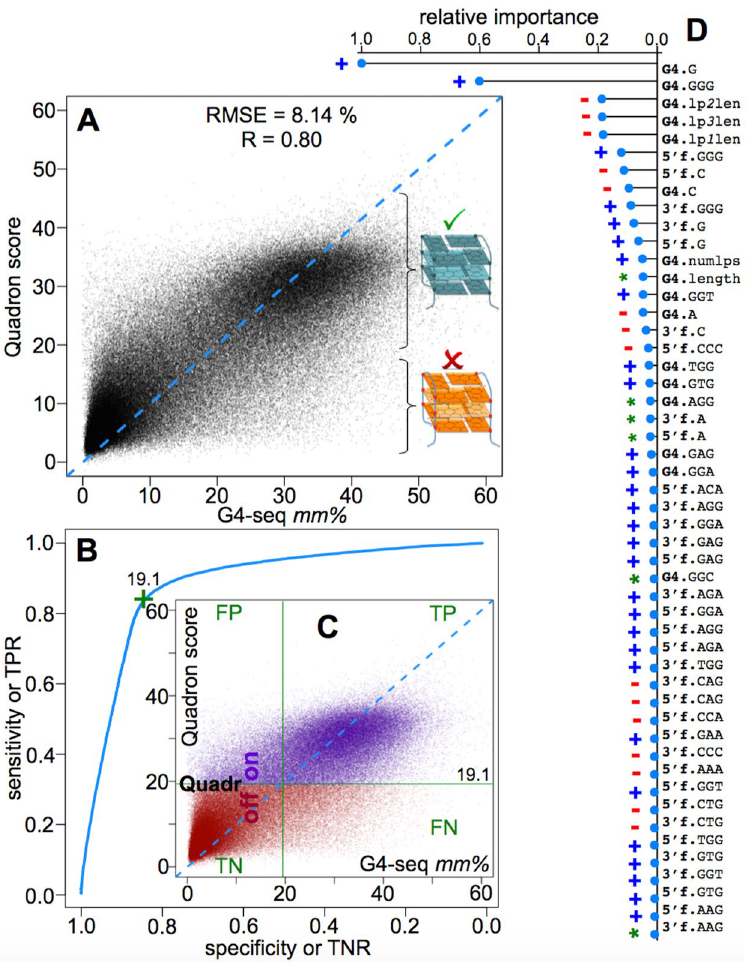
Figure 5. The performance of the final model. ( A – C ) show the Quadron performance against the experimental G4-seq dataset not used in the model development (correlation - A ; classification – ( B ) and ( C ). ( D ) presents the top 50 sequence-based features ranked by relative importance (fully listed in Table S3) for the achieved prediction quality. The feature names are explained in Methods. Blue ( + ), red ( − ) and green ( * ) marks highlight the features as generally G4-stabilising, generally G4-destabilising, and more complex respectively